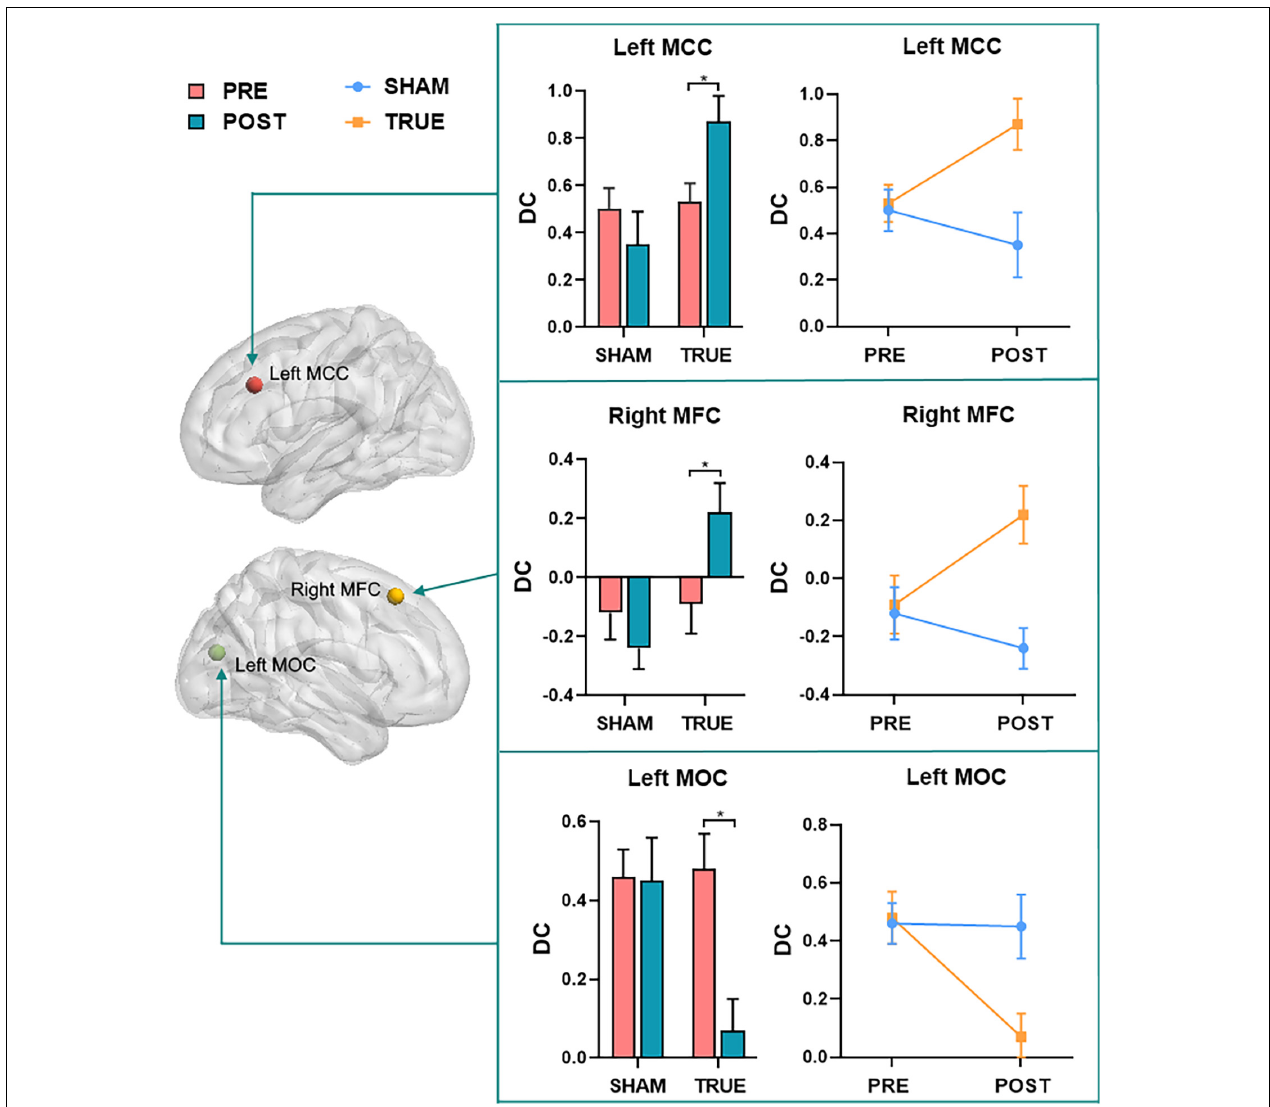
FIGURE 4 | A post hoc analysis of regions (left MCC, right MFC, and left MOC) with significant interactions found by repeated measures ANOVA. MFC, middle frontal cortex; MCC, middle cingulate cortex; MOC, middle occipital cortex; POST, patients with MCI after moxibustion treatment; PRE, patients with MCI